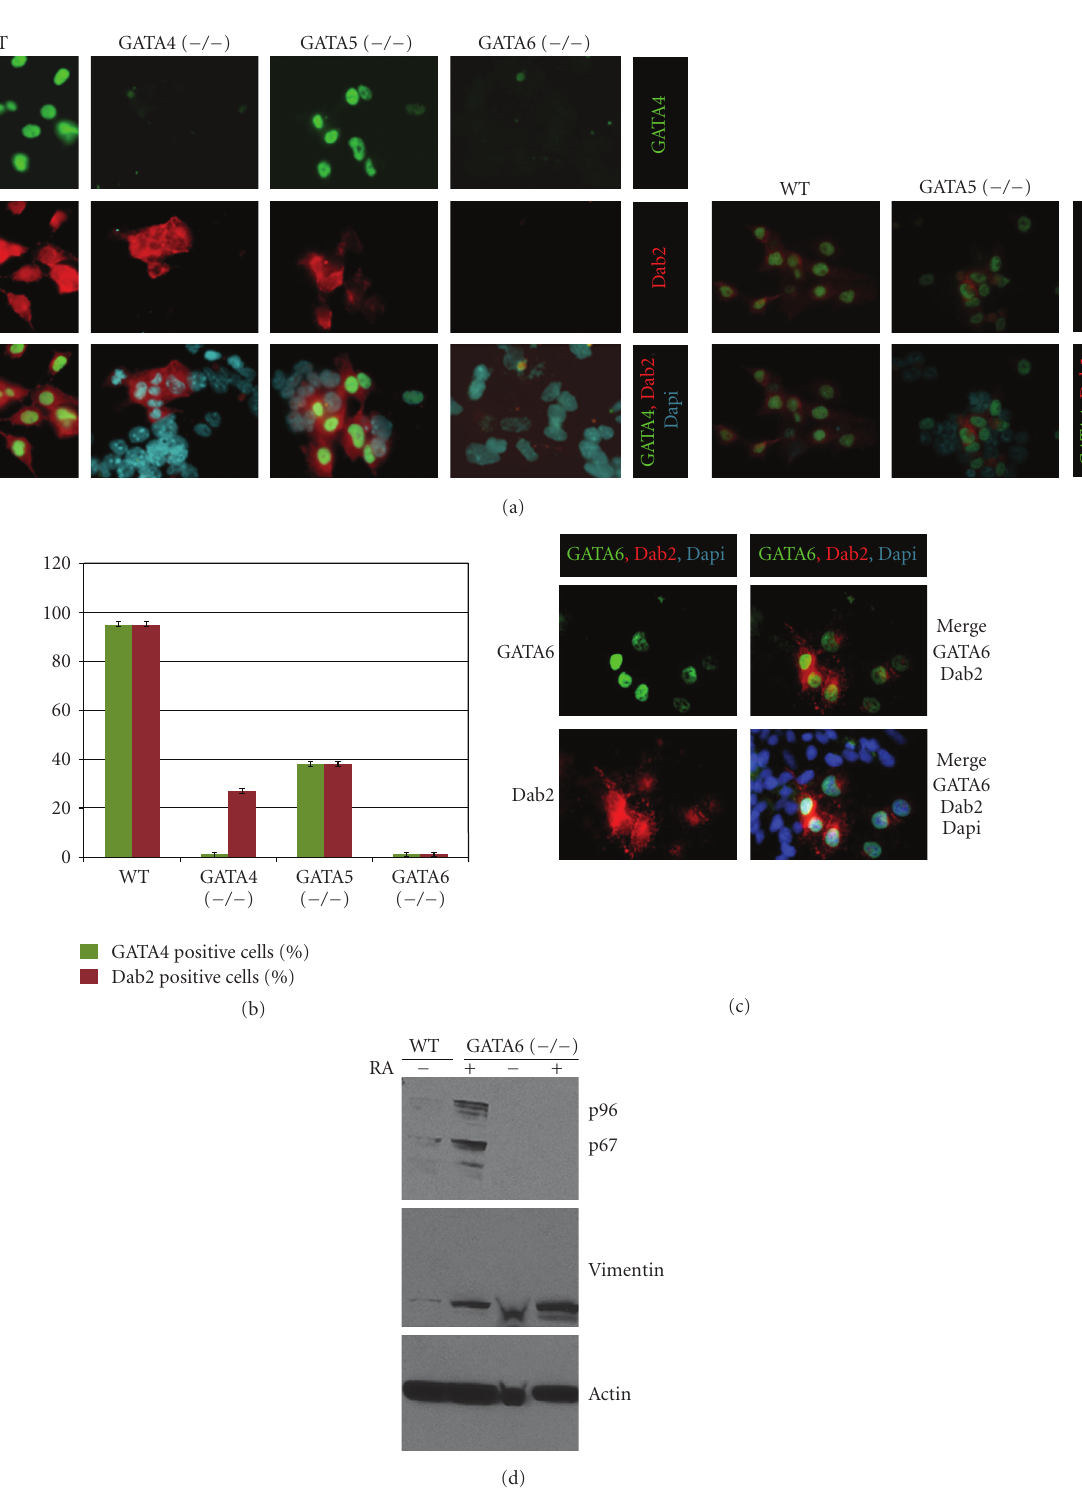
Figure 2: Retinoic acid-induced endoderm di ff erentiation of GATA-deficient ES cells in vitro: ES cells of wildtype, GATA4 ( − / − ), GATA5 ( − / − ), or GATA6 ( − / − ) genotypes in monolayers were treated with or without retinoic acid (1 μ M) for 4 days. Cells expressing Dab2 and GATA4 were detected following indirect immunofluorescence staining and counting under fluorescence microscopy. (a) Dab2 (red) and GATA4 (green) were detected under fluorescence microscopy with DAPI (blue) used for nuclear counterstaining. The percentage of Dab2 and GATA4 positive cells was determined by counting an average of 5 fields of cells. (b) The percentages of ES cells expressing GATA4 and Dab2 are presented in histogram. (c) In GATA4 ( − / − ) the expression of Dab2 correlates with the expression of GATA6. (d) Western blotting showing the absence of endoderm marker Dab2 and expression of mesoderm marker vimentin in GATA6 ( − / − ) ES